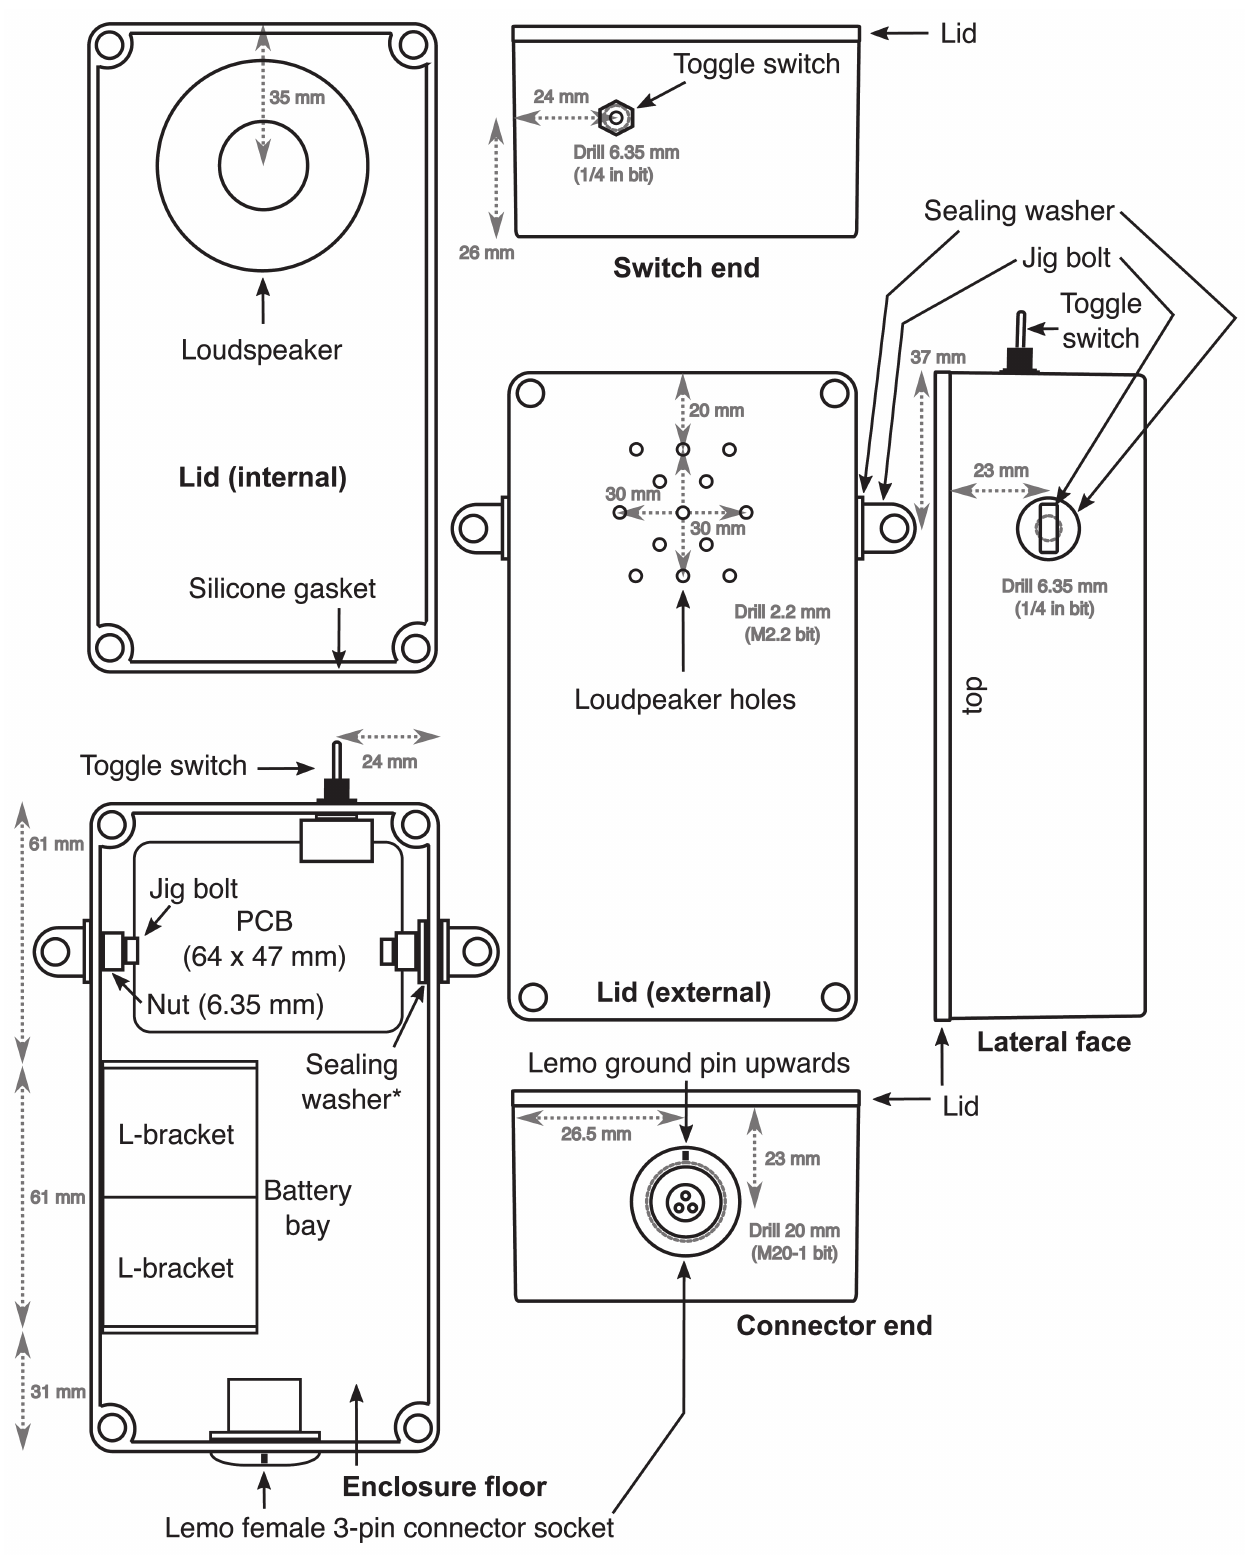
Fig. 5. Design schematic for electric fish finder enclosure. Grey arrows show distances from edges to the center of drill holes/ objects. Grey dotted circles represent drill holes. The sealing washer marked with an asterisk has no waterproofing function and is used instead to trap the exposed terminal of a wire from the channel ground against the internal metal surface of the enclosure (see CHGND in Fig.